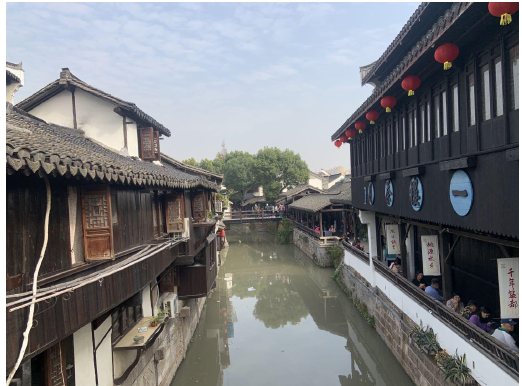
Figure 5 . On Hongfu Bridge looking East (Photo by the author)